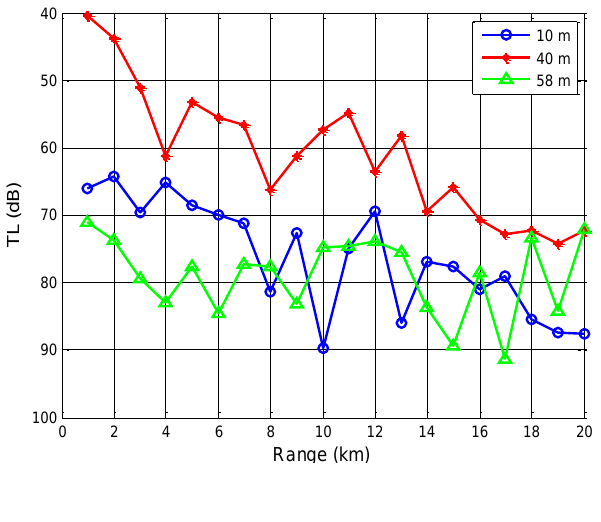
Figure 13. Transmission loss vs. range, under different receiver